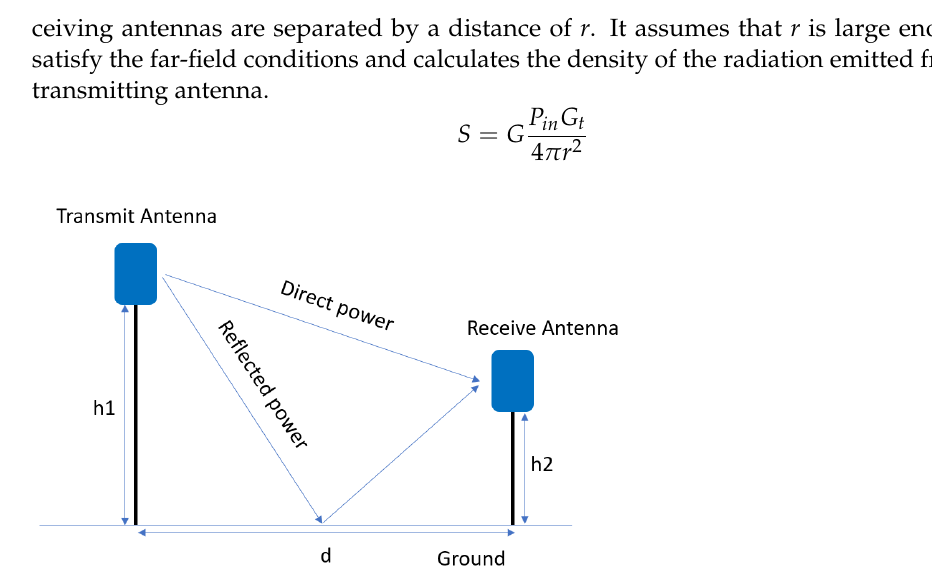
Figure 6. Friis transmission formula application environment.